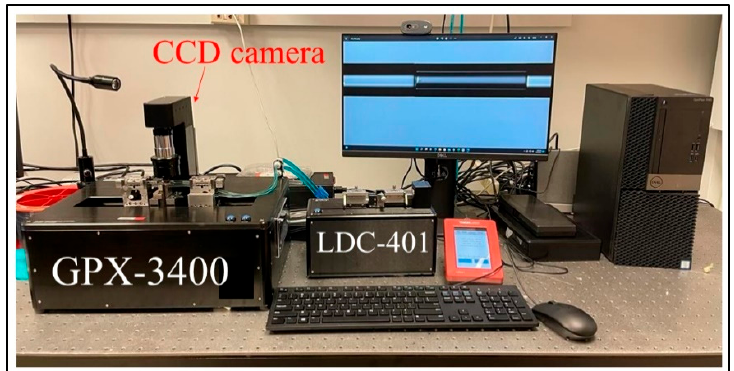
Figure 2. Splicing and cleaving setup for fabrication of the proposed sensor.